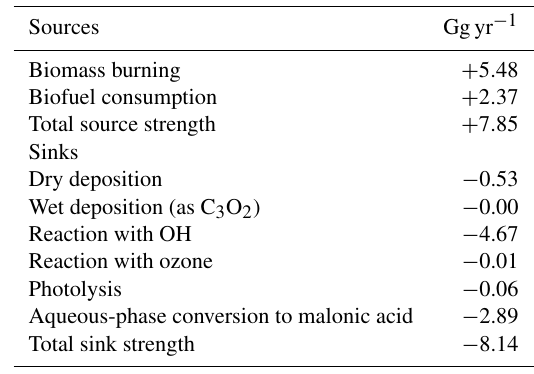
Figure 12. PTR-TOF-MS measurement of carbon suboxide and dif- ferent flows of synthetic air through the aqueous solution (pH6). Inset: example of C 3 O 2 loss from the solution, the corresponding ln( c 0 /c t ) values and the linear fit, at 150cm 3 min − 1 synthetic air flow. Table 3. Global budget of carbon suboxide. The global burden is